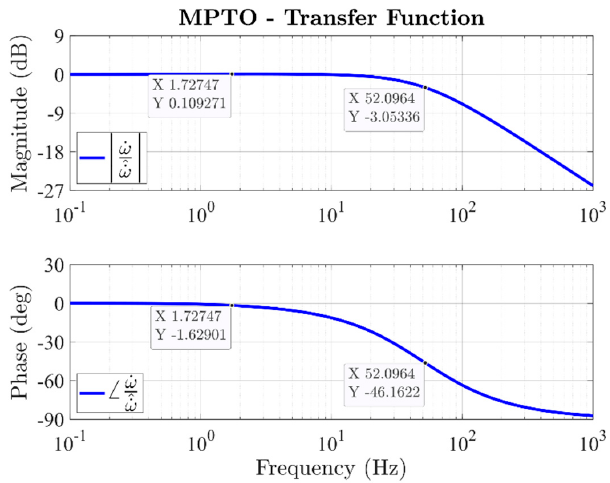
Figure 13. Bode plot of the acceleration-tracking transfer function.